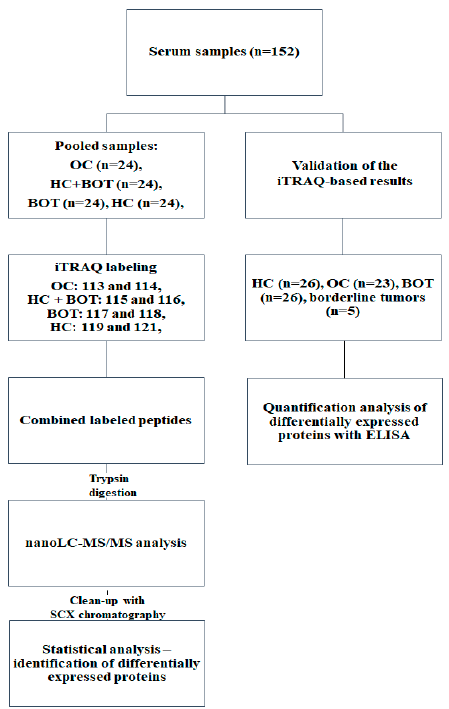
Figure 1. Schematic workflow of the study. Three groups of samples were analyzed: OC ovarian cancer; BOT benign ovarian tumor; HC healthy controls.